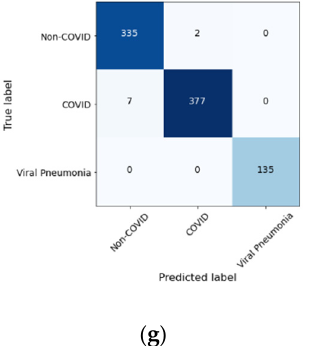
Figure 13. Confusion Matrix for Deep CNN Models ( a ) VGG-19 Model, ( b ) Inception-v3 Model, ( c ) ResNet-152-v2 Model, ( d ) InceptionResNet-v2 Model, ( e ) DenseNet-201 Model, ( f ) Xception Model, ( g ) EfficientNet-b7 Model, ( h ) label.